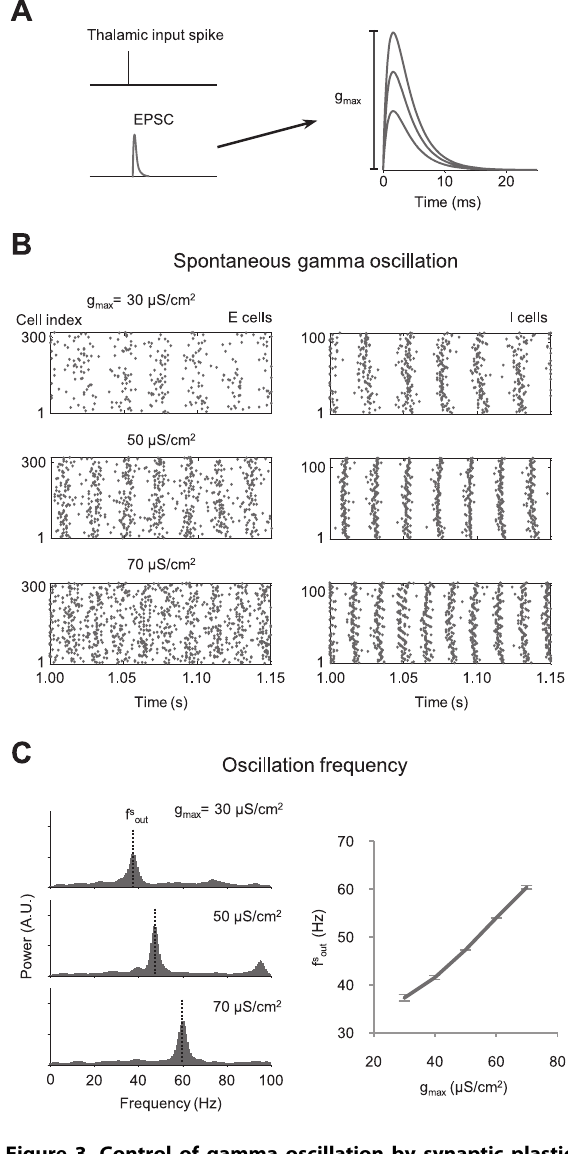
Figure 3. Control of gamma oscillation by synaptic plasticity. (A) The amplitude (g max ) of excitatory postsynaptic conductance (EPSC) by thalamocortical input spikes is controlled as a simulation of synaptic plasticity. (B) Spontaneous synchrony in the spike firings of E and I cells for various g max . (C) Spontaneous gamma oscillation frequency modulation by synaptic